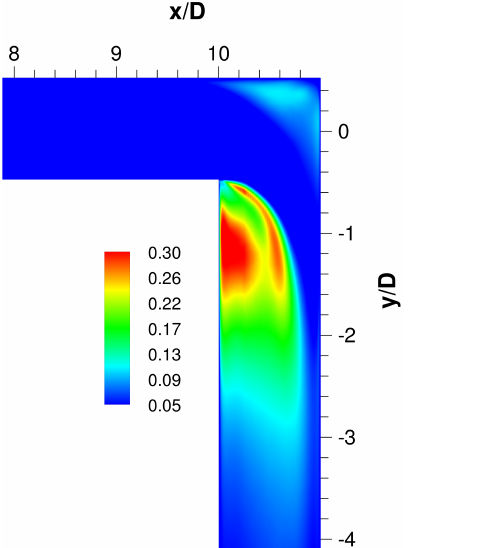
of the 90 ◦ case in the x – y b